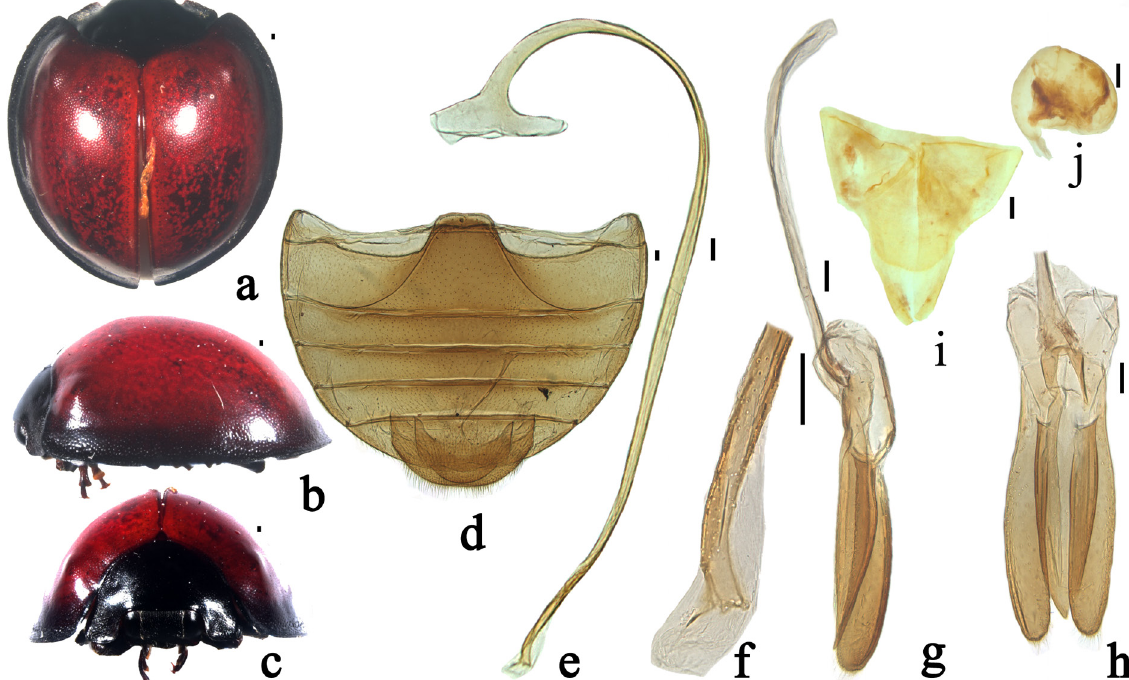
Fig. 6. Chilocorus rubidus Hope, 1831. a . Dorsal view. b . Lateral view. c . Frontal view. d . Abdomen. e . Penis. f . Apex of penis. g . Tegmen, lateral view. h . Tegmen, ventral view. i–j . Female genitalia: i . ovipositor. j . spermatheca. Scale bars: 0.1